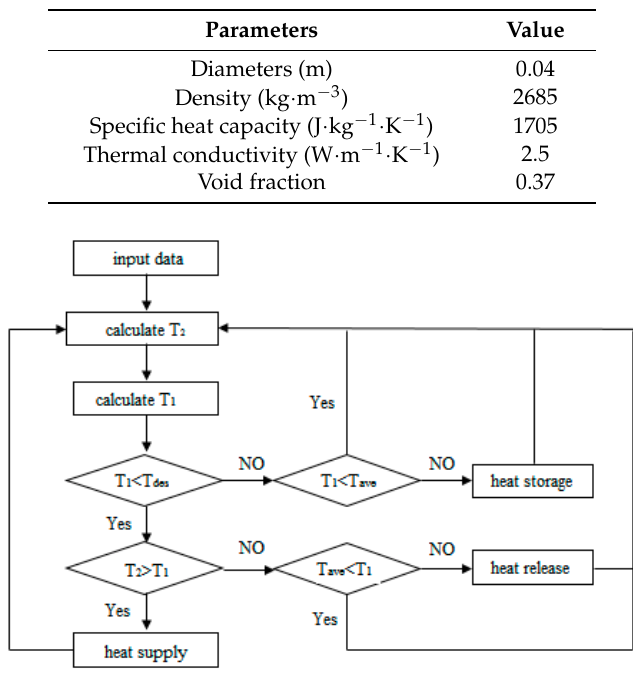
Figure 5. System operational flow chat.